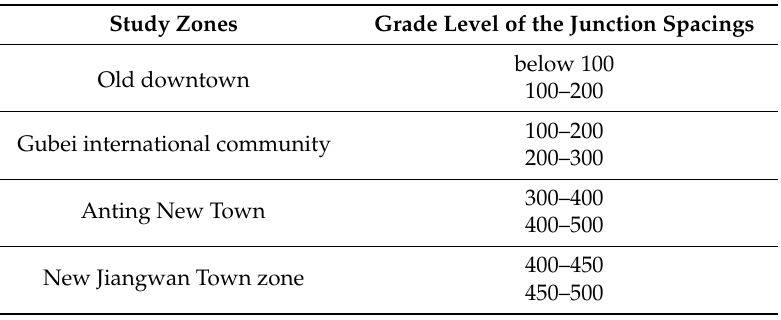
Table 4. Grade level of junction spacings in the four